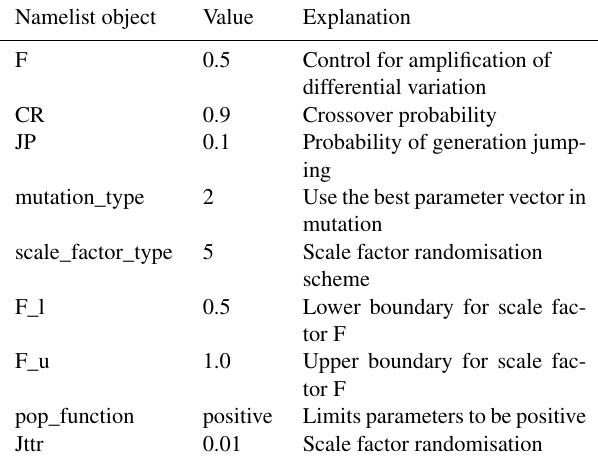
Table A4. Other settings of DE. Namelist